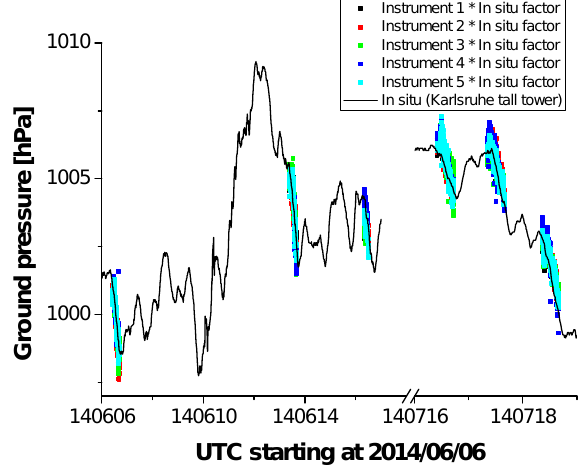
Figure 6. In situ pressure data from the Karlsruhe tall tower (http: //imkbemu.physik.uni-karlsruhe.de/~fzkmast/) together with pres- sure data calculated from total column amounts of O 2 and H 2 O. The column data is scaled with an in situ factor of 0.9700 for better comparability. Table 3. Calibration factor for XCO 2 and XCH 4 for the different instruments. Measurements were performed in Karlsruhe June and July 2014, in between the spectrometers were transported for cam- paign measurements.